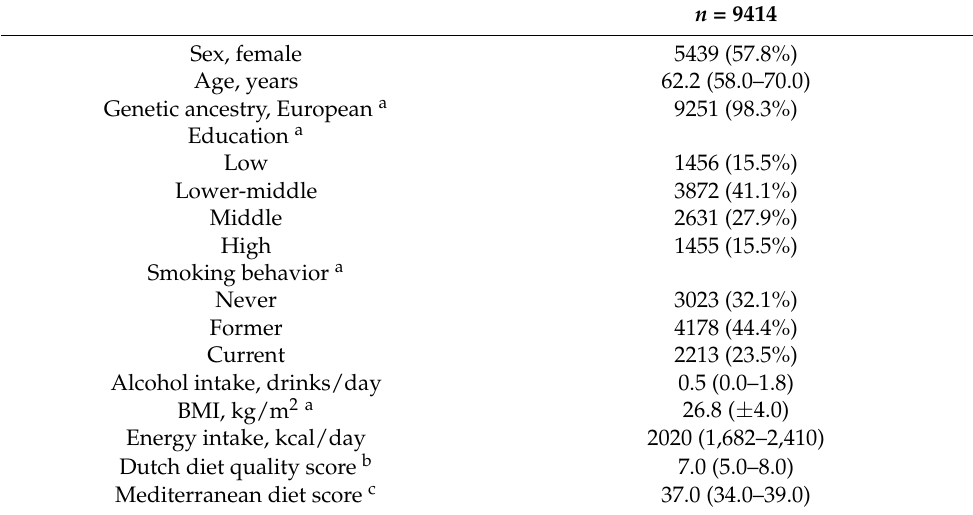
Table 1. Baseline